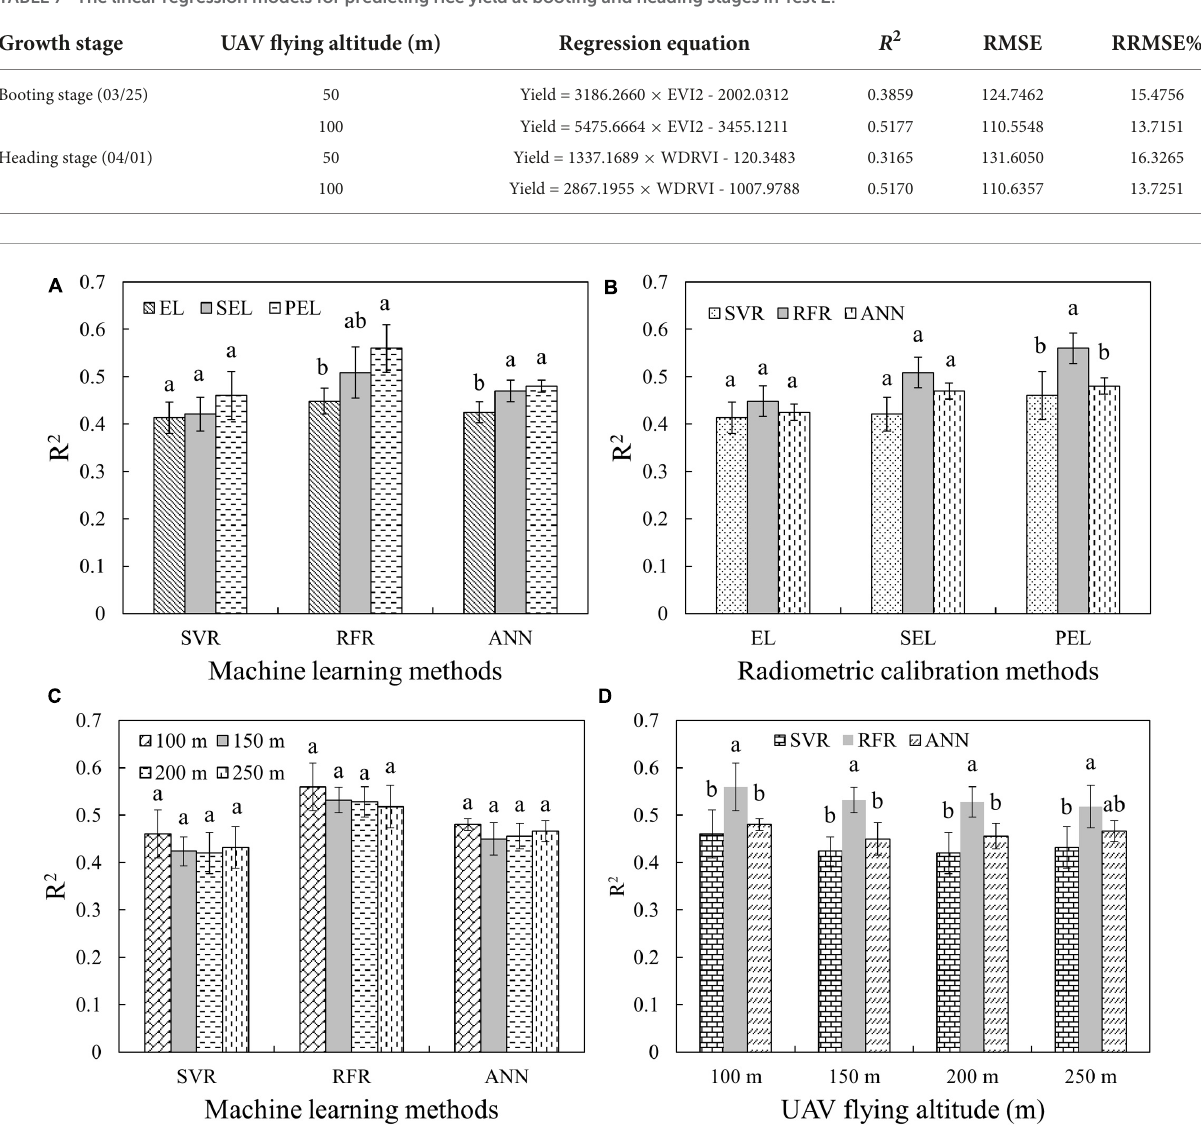
TABLE 7 The linear regression models for predicting rice yield at booting and heading stages in Test 2.